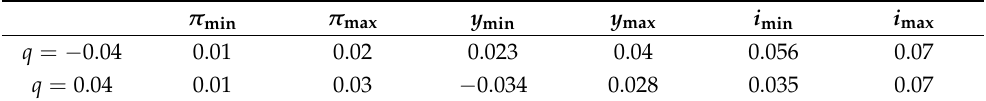
Table 1. Minimum and maximum viable values of inflation, output gap and interest rate (all in level terms) for v = − 0.005. π min π max y min y max i min